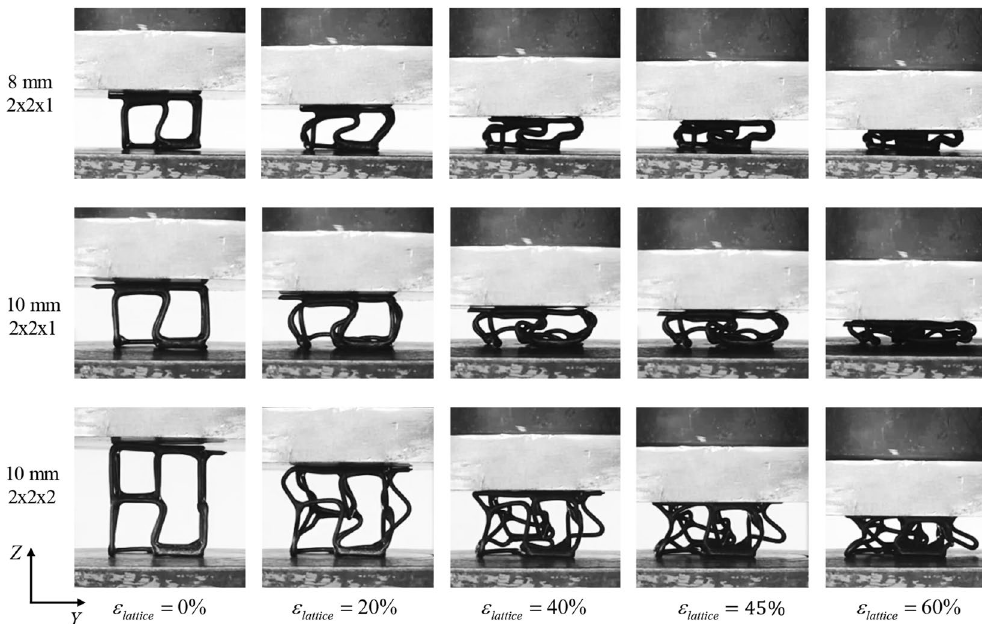
Figure 10. Compressing behavior of single stacked (2 × 2 × 1) 8 mm and 10 mm and double stacked (2 × 2 × 2) 10 mm cell size and lattice structures under Z-axis